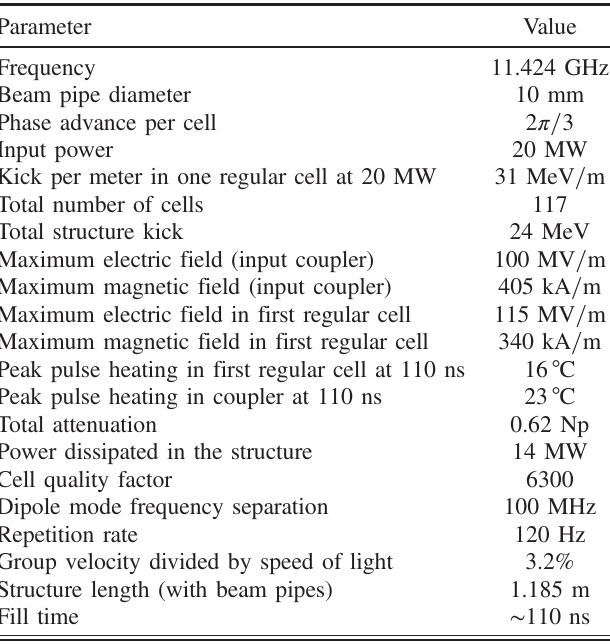
TABLE III. Parameters of an 11.424 GHz traveling wave